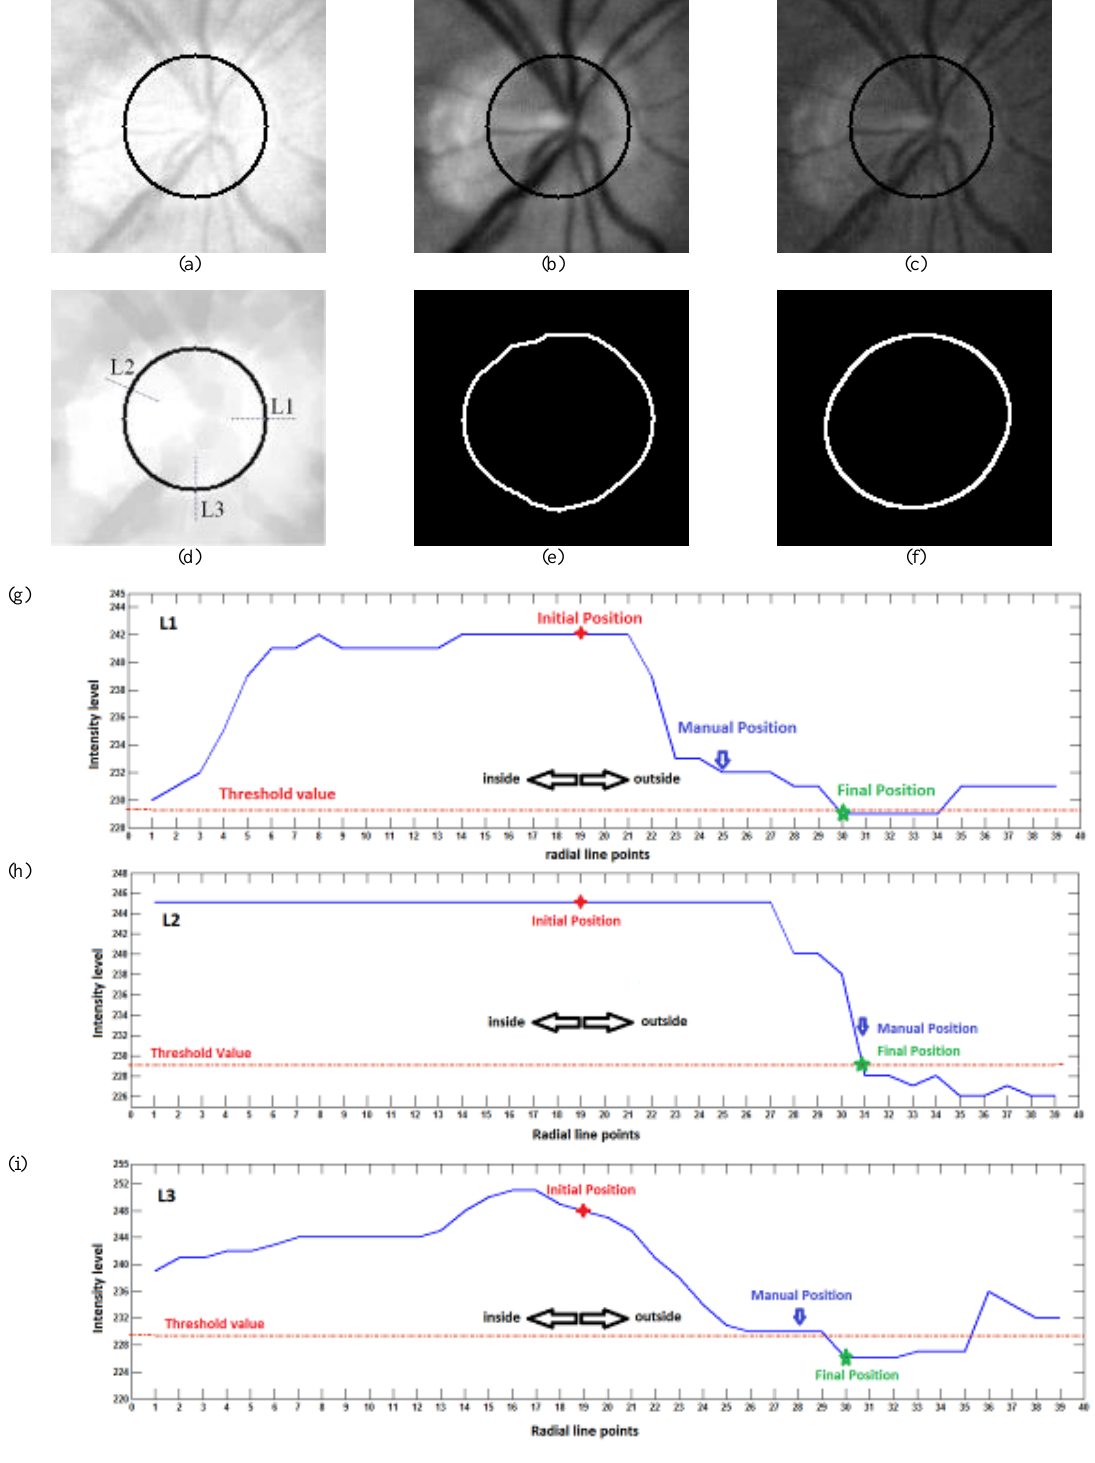
Figure 7. Details of radial analysis for adjusting border of optic disc. a) Initial optic disc circle on red channel (Initial Position). b) Initial optic disc circle on green channel. c) Initial optic disc circle on blue channel. d) Enhanced red channel for applying radial analysis method along with three radial lines L1, L2, and L3.) Finally, adjusted optic disc boundary (Final Position). f) True optic disc boundary extracted by expert (Manual Position). h-i) Details of applying radial analysis method on three radial lines L1, L2, and